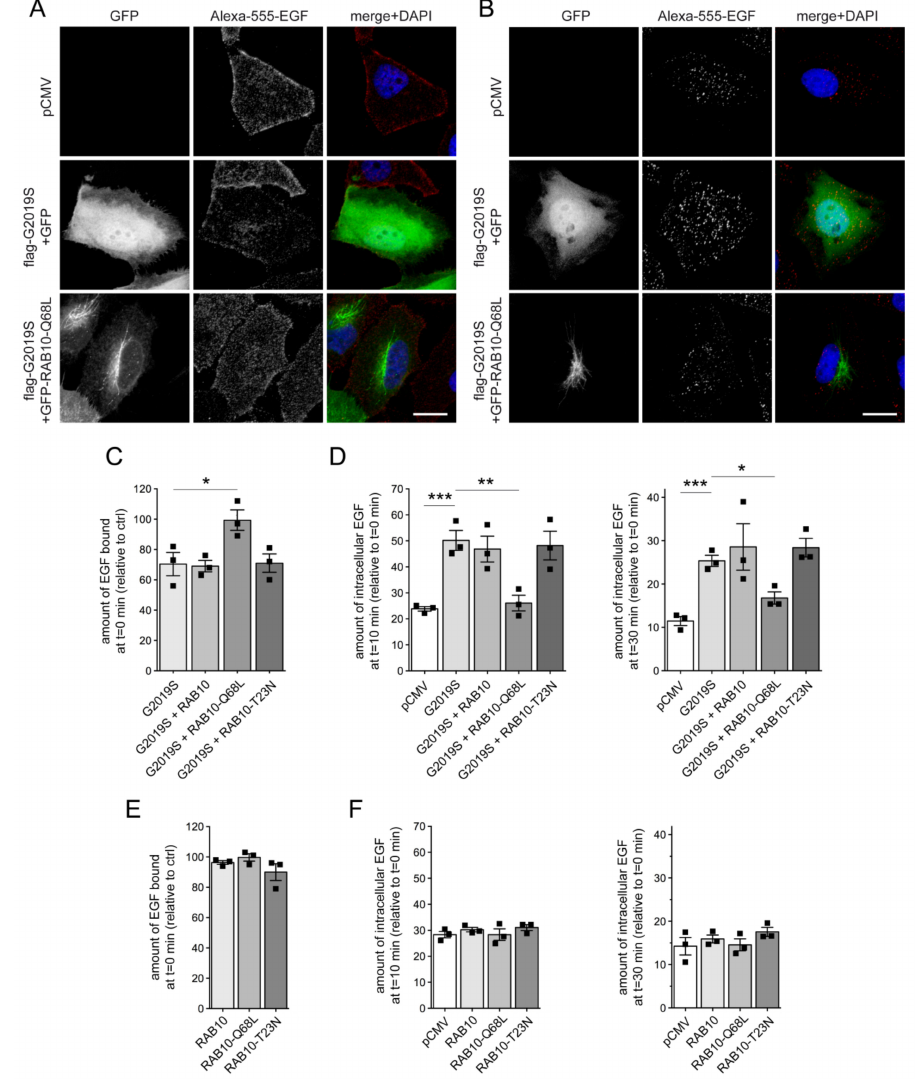
Figure 1. Active RAB10 rescues the G2019S leucine-rich repeat kinase 2 (LRRK2)-mediated deficit in epidermal growth factor (EGF) binding and degradation. ( A ) HeLa cells were transfected with either pCMV, or cotransfected with flag-tagged G2019S LRRK2 and GFP or GFP-tagged RAB10-Q68L as indicated. Cells were incubated with Alexa555-EGF for 20 min at 4 ◦ C, followed by washing to remove unbound fluorescent EGF before fixation (t = 0 min). Scale bar, 10 µ m. ( B ) Same as in ( A ), but upon incubation and washing, cells were shifted to 37 ◦ C for 10 min to allow for the internalization and degradation of fluorescent EGF. Scale bar, 10 µ m. ( C ) Cells were co-transfected with G2019S LRRK2 and either GFP, or GFP-tagged RAB10 constructs as indicated, and the amount of surface-bound fluorescent EGF was quantified. N = 3 experiments; * p < 0.05. ( D ) Cells were co-transfected as indicated, and the amount of internalized Alexa555-EGF in transfected cells was quantified after 10 min (left) and 30 min (right) of internalization, with values normalized to the amount of fluorescent EGF binding at t = 0. N = 3 experiments; * p < 0.05; ** p < 0.01; *** p <